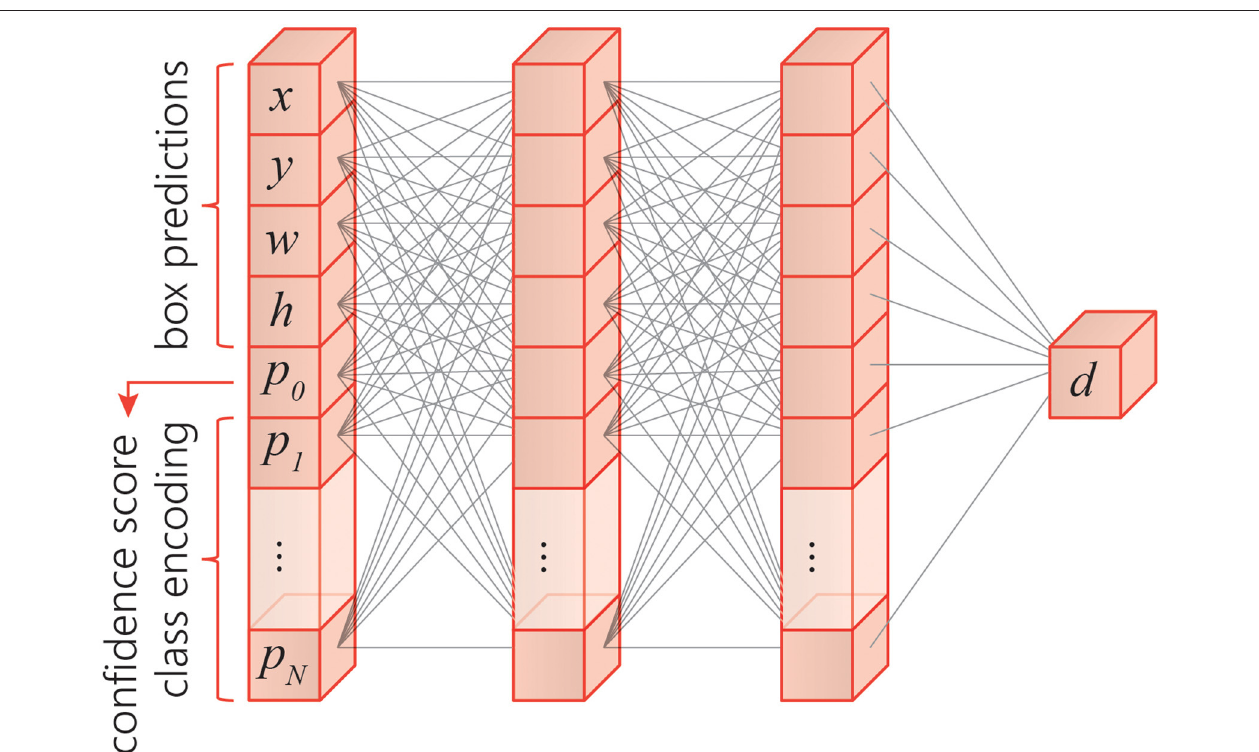
FIGURE 6 | Neural network model for predicting the relative distance of